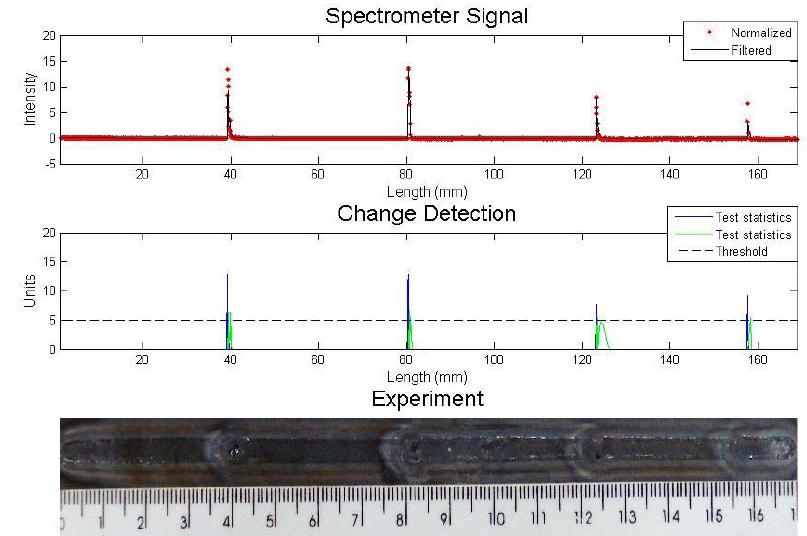
Figure 8. Experiment with sprayed water – analysis with Cusum LS